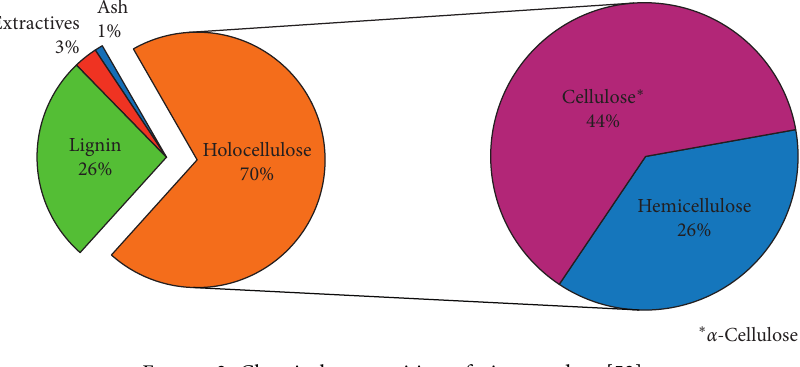
Figure 2: Chemical composition of pine sawdust [52]. Table 4: The elemental compositions of various